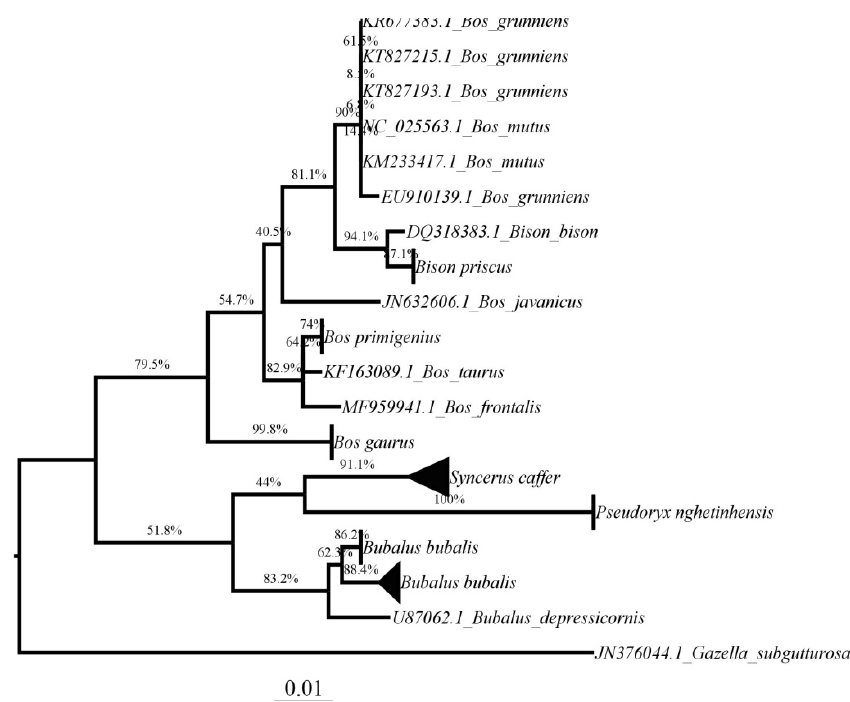
Fig. 1. Maximum Likelihood tree based on the Tamura 3-parameter distance using 16S ribosomal RNA ( 16S rRNA ) sequences; the numbers on each branch correspond to the bootstrap support. (percentages lower than 50 are not shown). The tree was rooted with G. subgutturosa ; [{( Bubalus bubalis + Bu. depressicornis )+ ( Pseudoryx nghetinhensis + Syncerus caffer )}+ { Bos gaurus + (( B. primigenius + B. taurus + B. frontalis )+ (( B. javanicus )+ ( Bison priscus + Bi. bison )+ B. grunniens + B. mutus